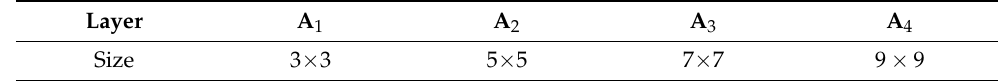
Table 1. Contrast Layer Dimensions.